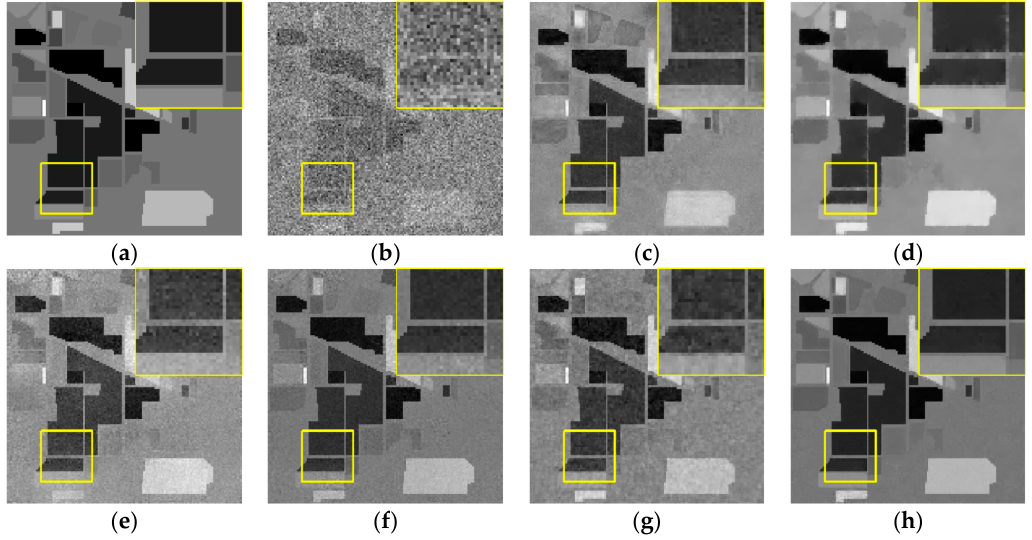
Figure 4. Denoised results of the 11 th band by different methods when the variance is 60: ( a ) original, ( b ) noisy, ( c ) HyRes, ( d ) LRTV, ( e ) LRMR, ( f ) NAIRLMA, ( g ) LRTDTV, and ( h ) proposed.